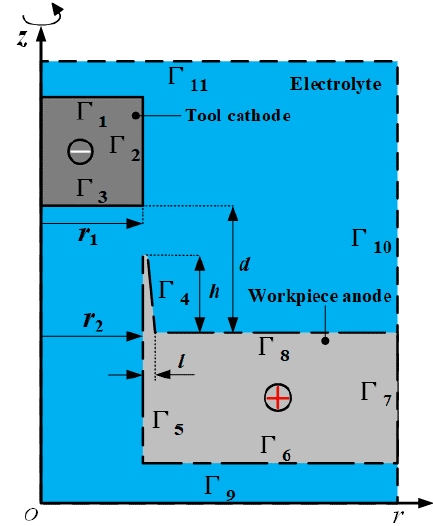
Figure 2. Simulation model.